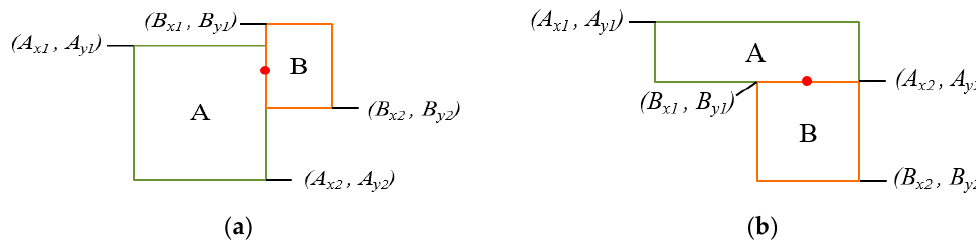
Figure 6. A representation of the creation method of the adjacent center point. ( a ) Horizontal overlapping case, ( b ) Vertical overlapping case.